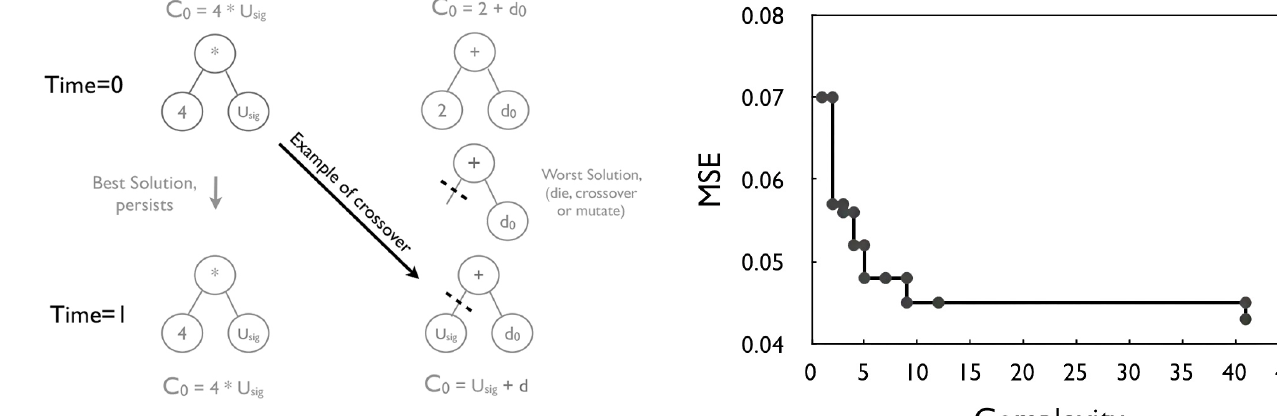
Figure 4. Example of the genetic programming process. Potential solutions are encoded as a population of trees. Here a hypothetical population of two solutions is shown. The first solution has a low MSE and therefore persists to the next iteration. The second solu- tion has a high MSE and therefore is subject to removal, mutation, or crossover. An example of “crossover” is shown here, whereby the old solution is combined with parts of other, better performing solutions to create a new potential solution in the next iteration.